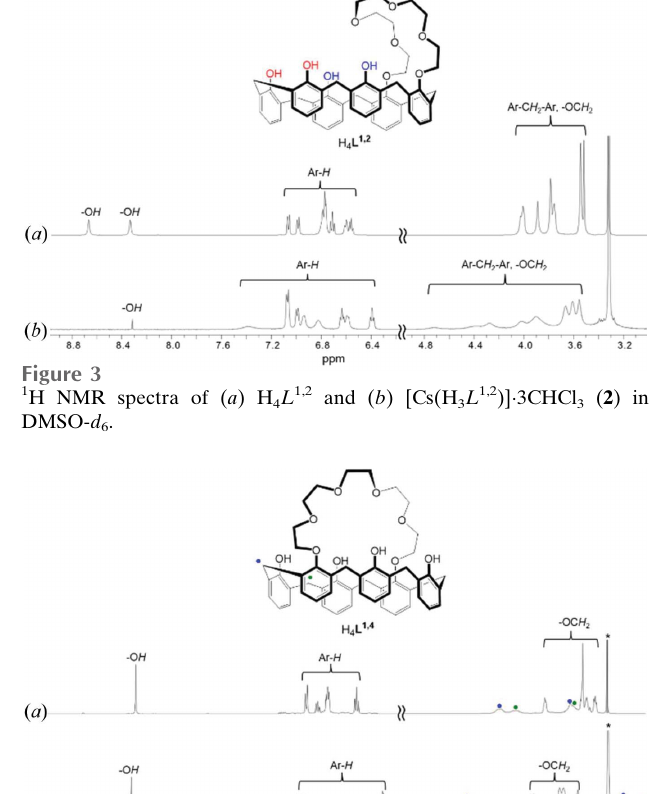
1,2 )] (cid:3) 3CHCl 3 L 3 ( 2 ) in